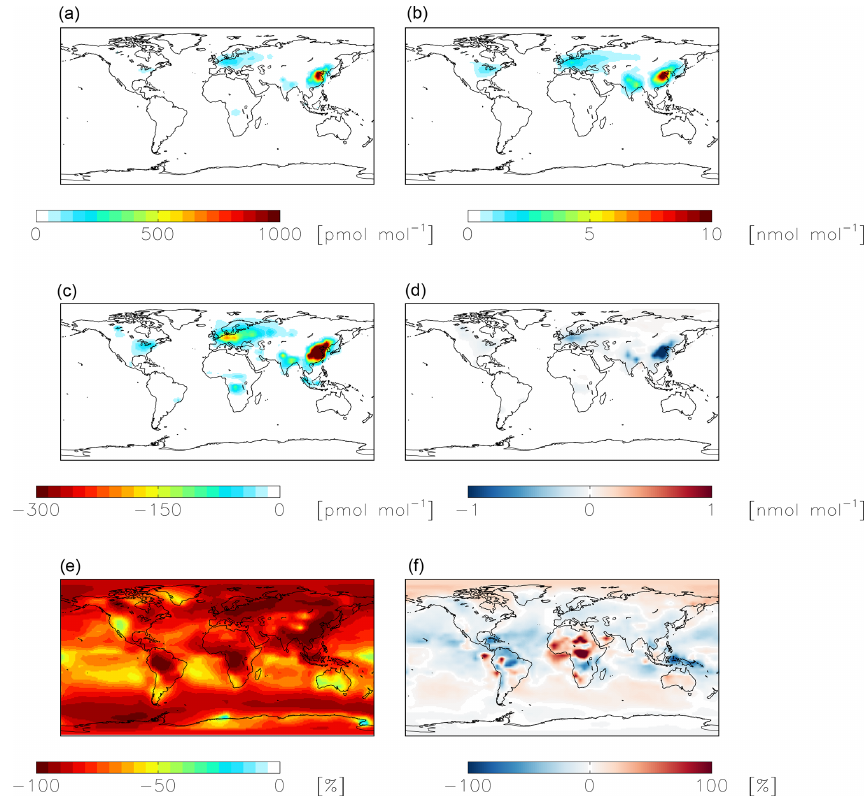
Figure 7. Modeled annual-mean HONO (a, c, e) and fine-mode nitrate (b, d, f) concentrations below 1km altitude in the standard simulation = 10 − 4 for NO (a, b) with γ NO 2 hydrolysis. Absolute (c, d) and relative (e, f) change in concentrations below 1km altitude between the 2 = 10 − 7 . Negative numbers represent a decrease relative to the standard standard model and the model simulation with γ NO 2